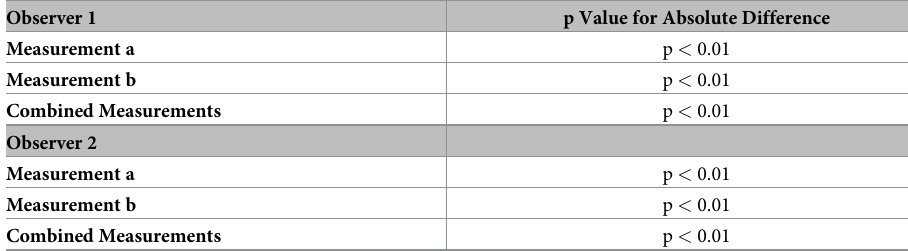
Table 3. Student t test for change in joint line height with raTKA and conventional TKA.